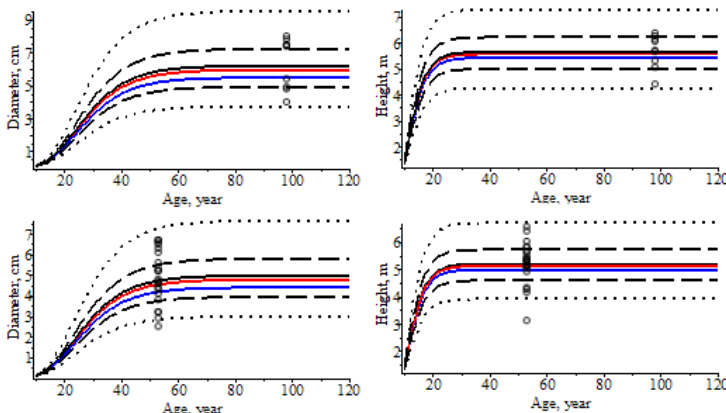
Figure 3. Dynamics of the mean, mode, median, 5% quantile, 95% quantile, and lower- and upper-quartile trajectories for two stands within the validation dataset: top—the first stand; bottom—the second stand; mean—solid line in black; median—solid line in red; mode—solid line in blue; 5% and 95% quantiles—dotted lines; lower and upper quartiles—dashed lines; values are shown as circles.